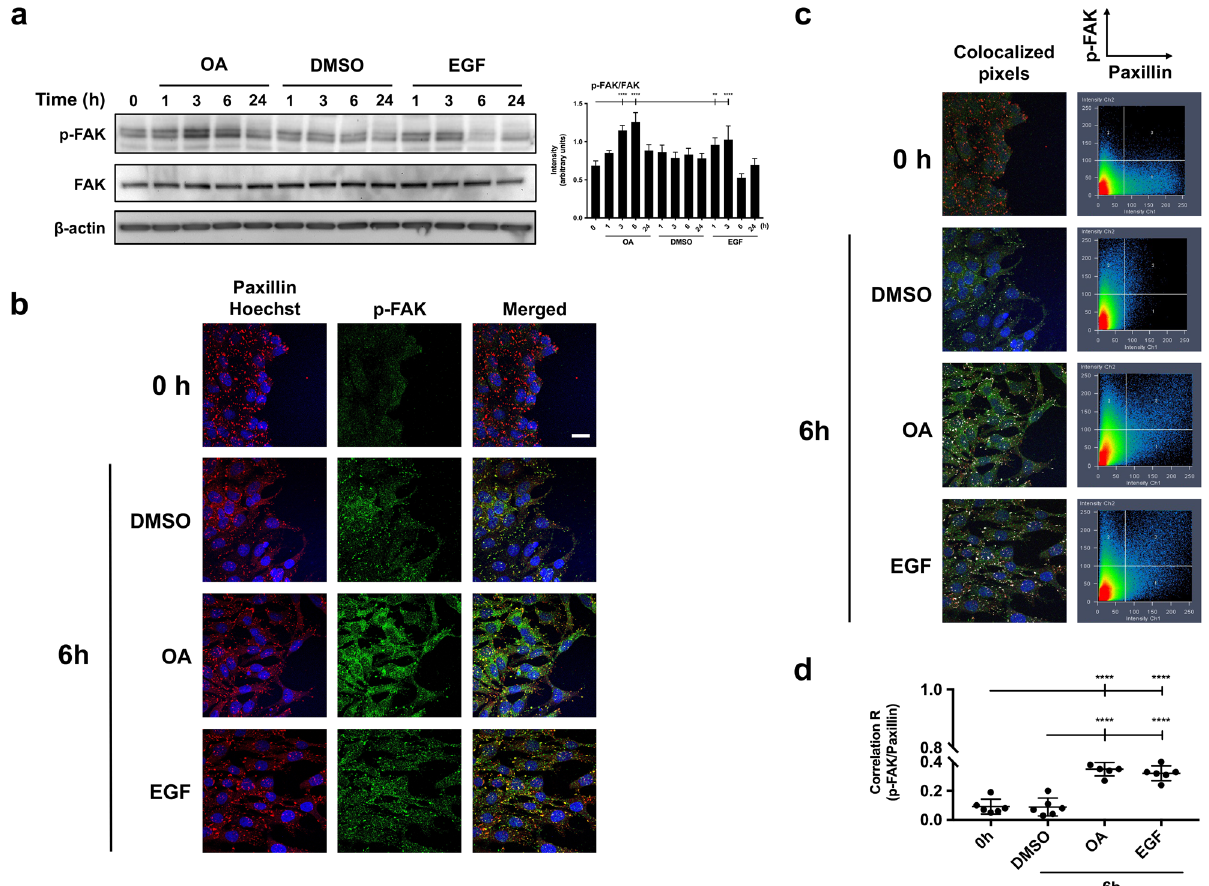
Figure 7. OA induces FAK phosphorylation and promotes its localization in focal adhesion with paxillin in Mv1Lu cells. ( a ) The activation of FAK was assessed by Western Blot at Tyr 925, at the indicated times in the presence of 5 µM OA, DMSO equivalent volume or EGF. Additionally, total protein expression was assayed: FAK. β-Actin was used as a loading control. Phospho-FAK intensity values in Western-blot were quantified by ImageJ to conduct a one-way ANOVA analysis showed on the plot (*p < 0.05, **p < 0.005, ***p < 0.001 and ****p < 0.0001). ( b ) Confluent Mv1Lu cells were scratched and allowed to migrate for 6 h. Pictures show the immunostaining with specific antibodies against phospho-FAK (Tyr 925) and paxillin. Co-staining with Hoechst-33258 was used to reveal nuclei. P-FAK: green. Paxillin: red. Nuclei: blue. ( c ) Pictures and graphs represent a colocalization analysis performed by Zeiss Efficient Navigation (ZEN) software. Colocalized pixels are highlighted in white at the immunostaining images. Graphs are dot plots representing both p-FAK and paxillin intensities in terms of number of pixels: p-FAK pixels on Y axis and paxillin pixels on X axis. The 3 quadrant (upper right) represents overlapped (common) pixels between both proteins. ( d ) Pictures of each condition (two) were divided in three horizontally distributed sectors. Pearson’s correlation coefficient in each sector of each condition was calculated by the average pixel intensity of p-FAK and paxillin overlapped pixels. The plot represents Pearson’s correlation values for each condition, each dot representing the value obtained in one sector. Asterisks indicate statistically significant differences between conditions according to one-way ANOVA statistical analysis: (*p < 0.05, **p < 0.005, ***p < 0.001 and ****p < 0.0001). This experiment was repeated at least three times. Representative images are shown. Scale bar indicates 10